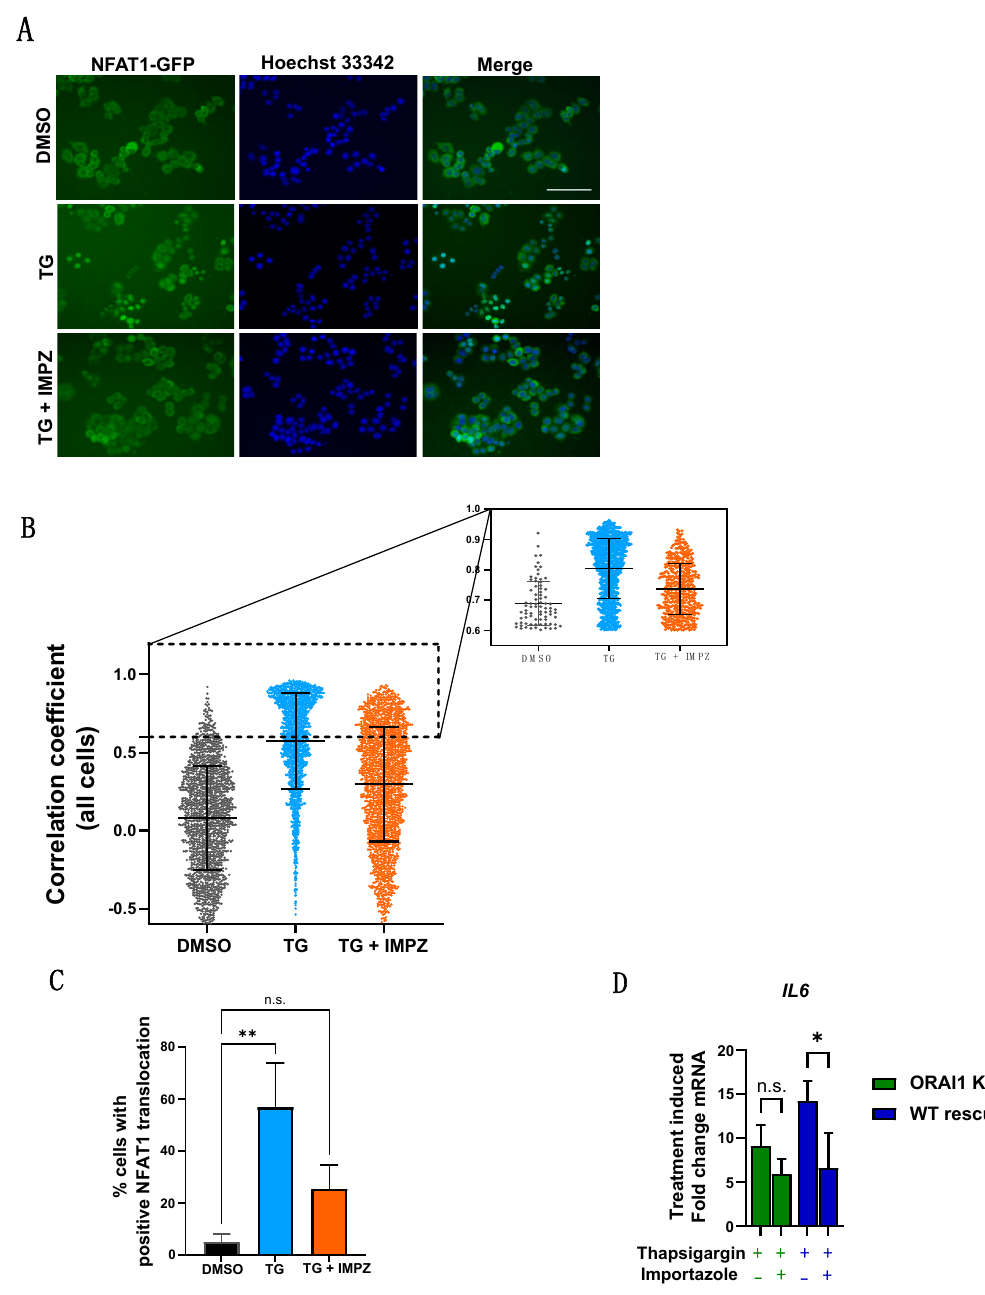
Figure 5. Importazole blocks thapsigargin-mediated NFAT1-GFP translocation. ( A ) Representative images of NFAT1-GFP (green) expressing MDA-MB-468 cells and Hoechst nuclear staining (blue) treated with DMSO control (top) and thapsigargin (TG) (middle) as well as pre-treated with importa- zole (IMPZ) for 15 min prior to 1 h TG treatment (bottom). Scale bar = 100 µ m. ( B ) Quantification of single cell NFAT1-GFP translocation following treatment with DMSO, TG, or TG + IMPZ from three independent experiments and represents mean ± SD. Inset corresponds to cells with NFAT1-GFP positive translocation (correlation coefficient > 0.6). ( C ) Percentage of cells with NFAT1-GFP translo- cation from three independent experiments and represents mean ± SD (n.s., not significant ( p ≥ 0.05); ** p < 0.01), one-way ANOVA with Dunnett’s post-hoc). ( D ) Bar graphs showing IL6 mRNA fold change induced by 1 h treatment with thapsigargin or thapsigargin/importazole in MDA-MB-468 ORAI1 knockout and ORAI1 WT rescue cells from three independent experiments and representing mean ± SD (n.s., not significant, ( p ≥ 0.05), * p < 0.05, two-way ANOVA with Šid á k’s